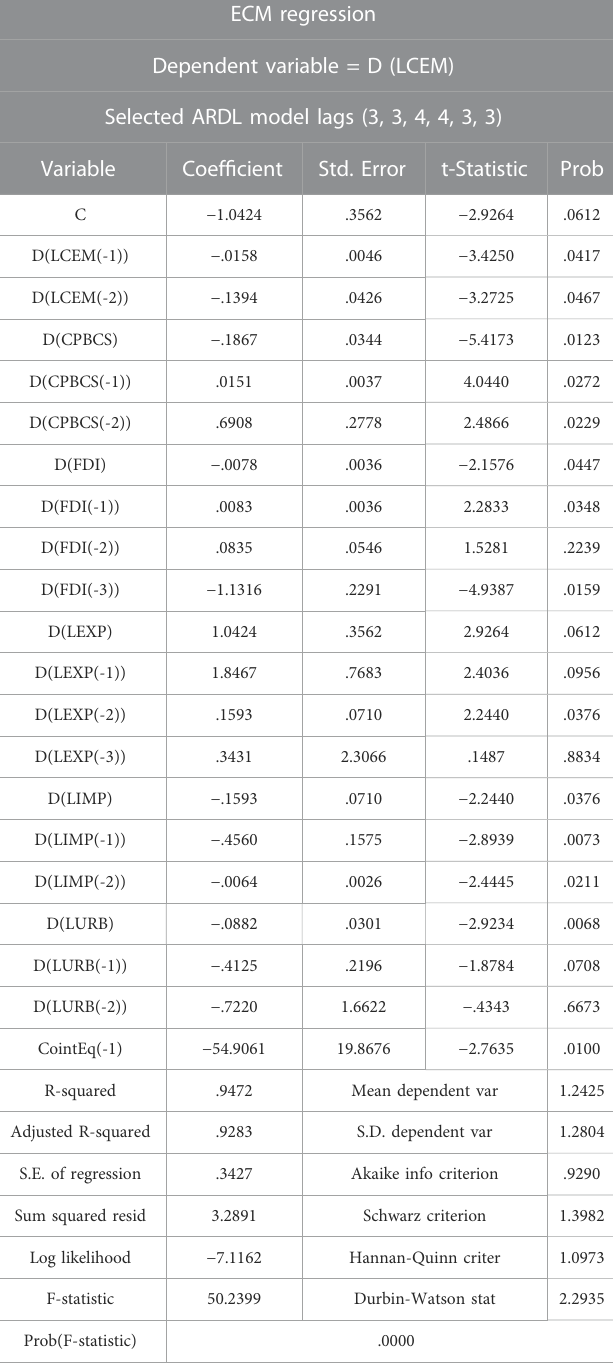
TABLE 6 Results of error correction model. ECM